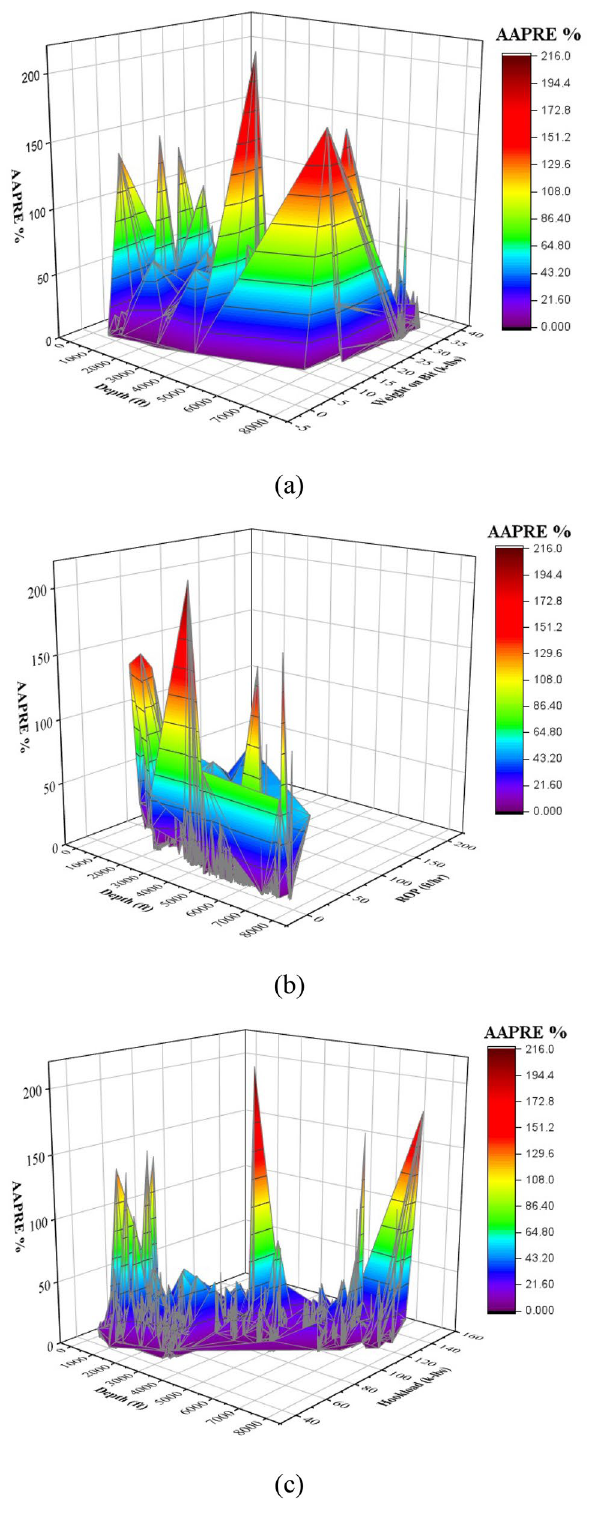
Figure 13. Absolute relative error contour versus different parameters ( a ) WOB and depth ( b ) ROP and depth ( c ) hook load and